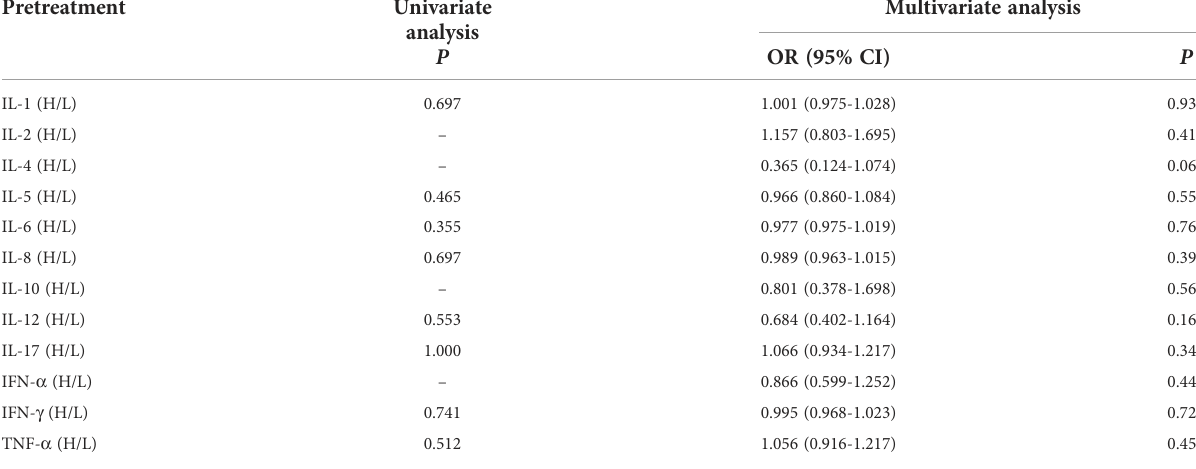
TABLE 7 Univariate and multivariate analysis results of baseline cytokine levels between CB and NCB.